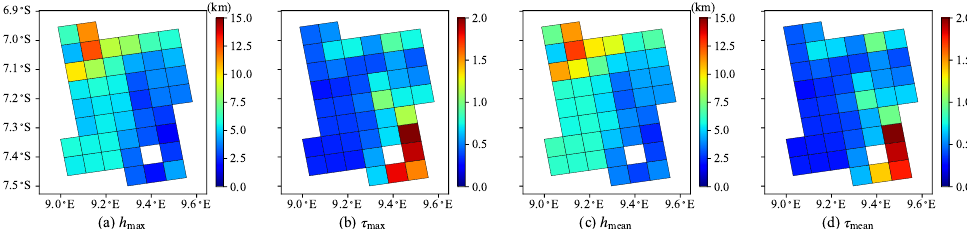
Figure 15. The maximum solution estimates ( h max , τ max ) and the mean solution estimates ( h mean , τ mean ) for Set 1 and data on 4 July 2019.